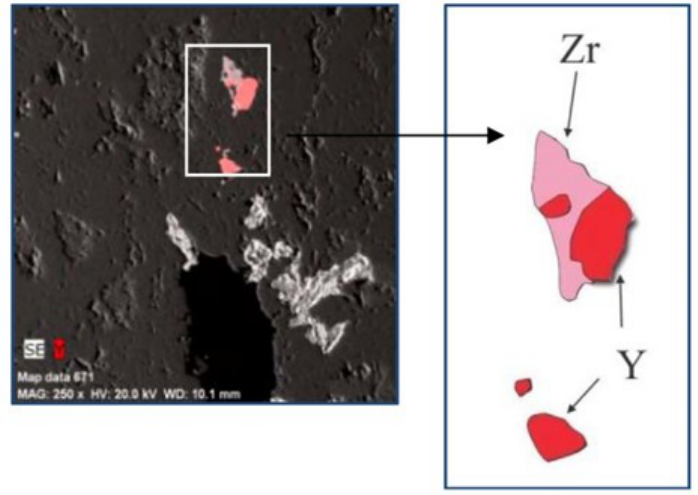
Fig. 14. Xenotime-zircon grain (Zoom 250X, HV 20.0, WD 10.1